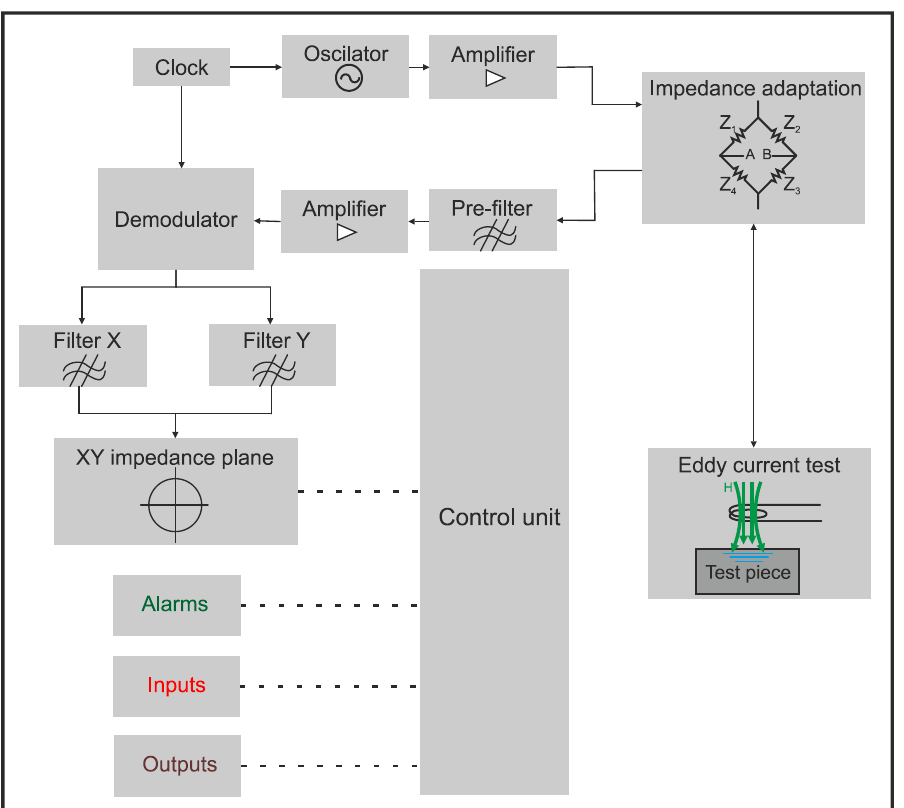
Figure 5. Block diagram of an analog eddy current